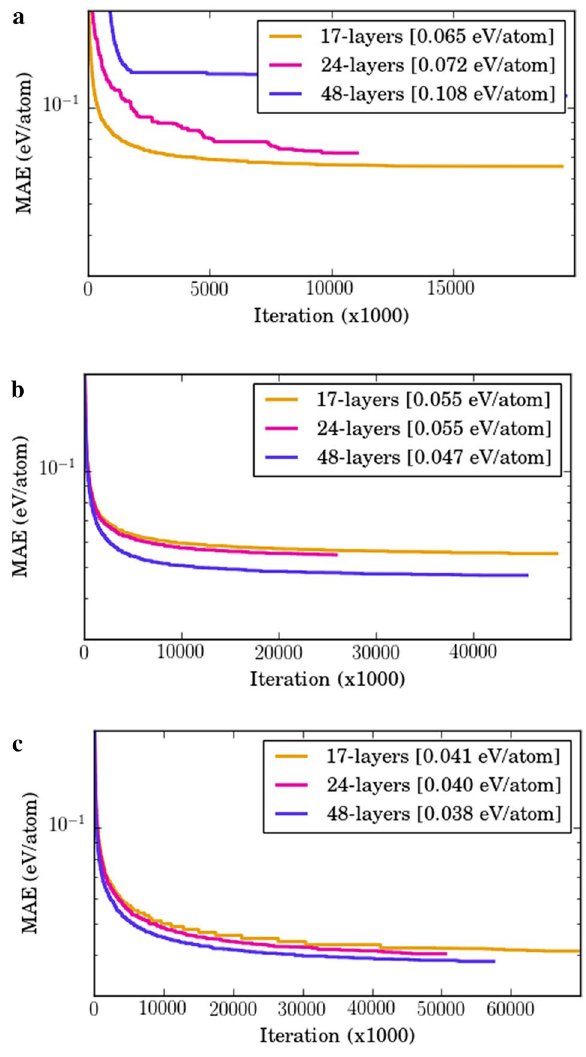
derived physical attributes on the OQMD-SC. They are trained using 9:1 random train:test splits (test set is same as validation set). Plain Network do not have shortcut connections; stacked residual network (SRNet) places shortcut connection after stacks of multiple layers; individual residual network (IRNet) leverage individual residual learning around each layer. The three subplots shows the validation error curves during training for each network; x-axis represents the training iteration (x1000) and y-axis represents the MAE. The models are implemented using TensorFlow and trained using Adam optimizer with a mini batch size of 32 and a